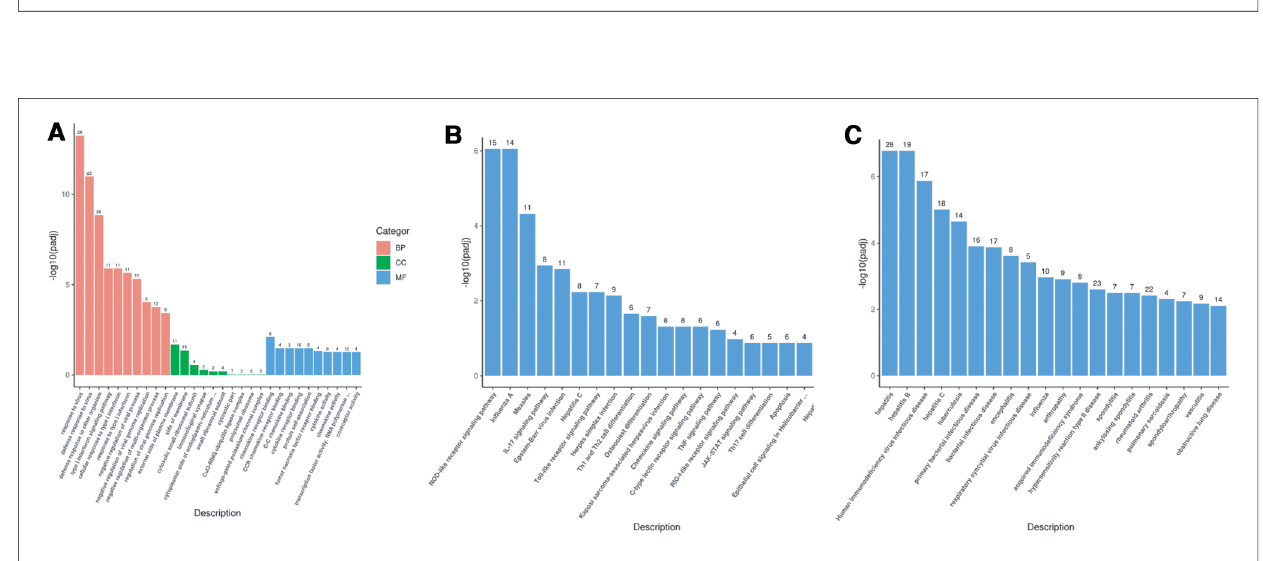
FIGURE 5 ( A ) GO enrichment analysis bar chart; ( B ) KEGG enrichment analysis bar chart; ( C ) DO enrichment analysis bar